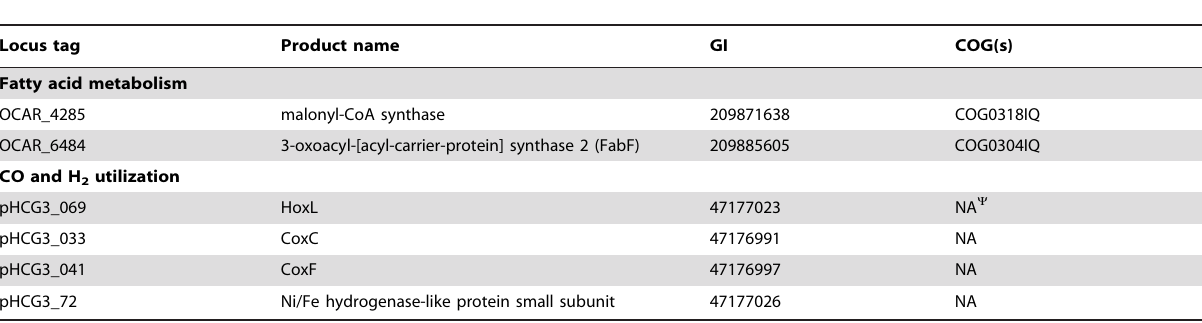
Table 3. Fatty acid metabolism and carbon fixation proteins expressed during growth in syngas.